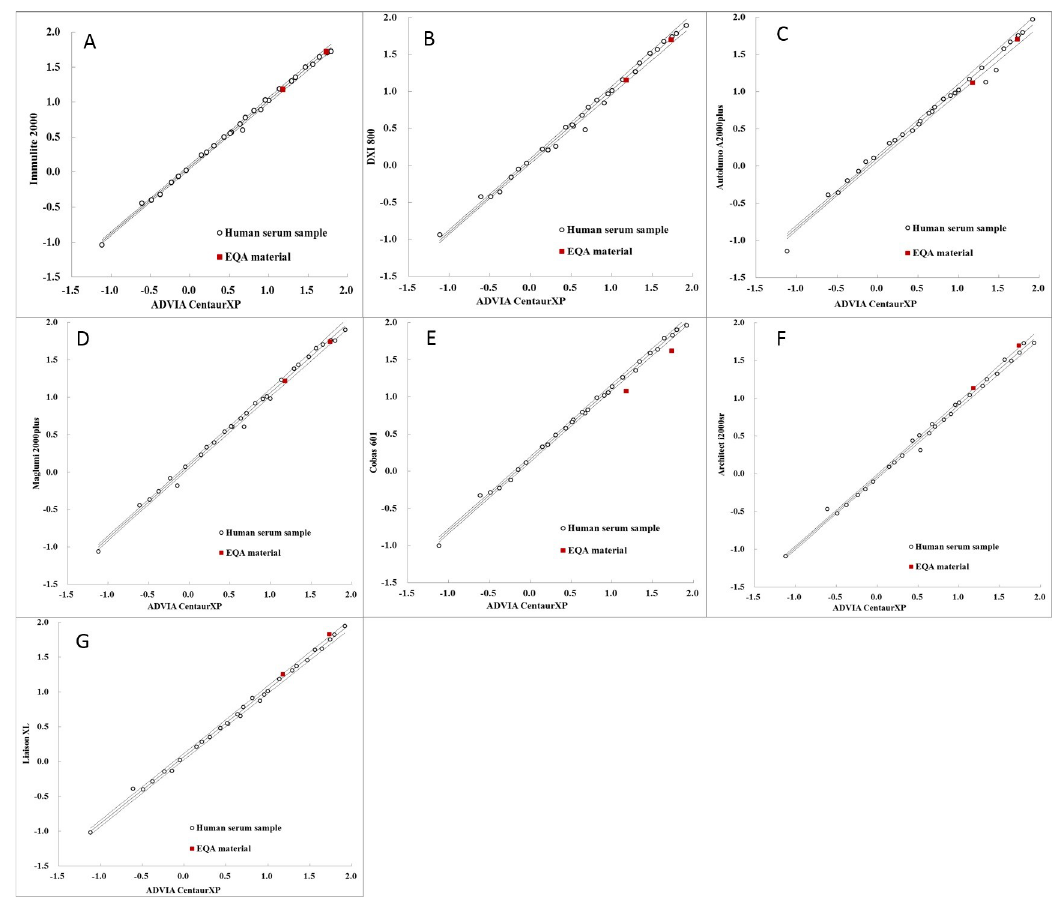
Fig 3. Commutability of National Center for Clinical Laboratories external quality assessment (EQA) materials among the eight assessed thyroid-stimulating hormone (TSH) instrument platforms based on CLSI